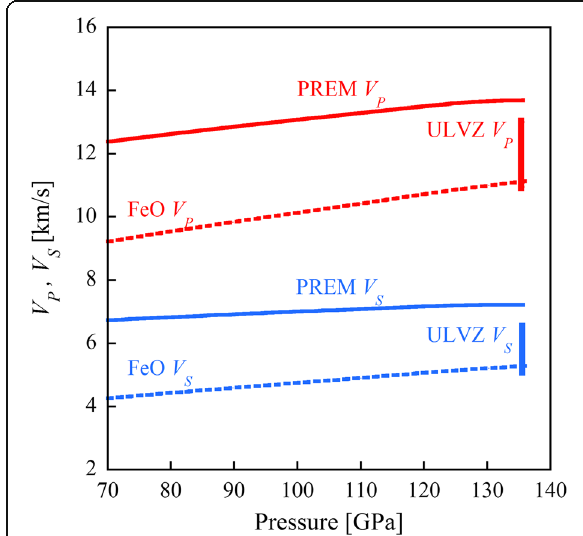
Fig. 7 Comparison of the sound velocities of wüstite with those of PREM and ULVZs. The V P and V S profiles of wüstite are shown by broken lines as a function of pressure along the mantle geotherm (Brown and Shankland 1981). The V P and V S profiles for PREM are plotted by solid lines with those of the